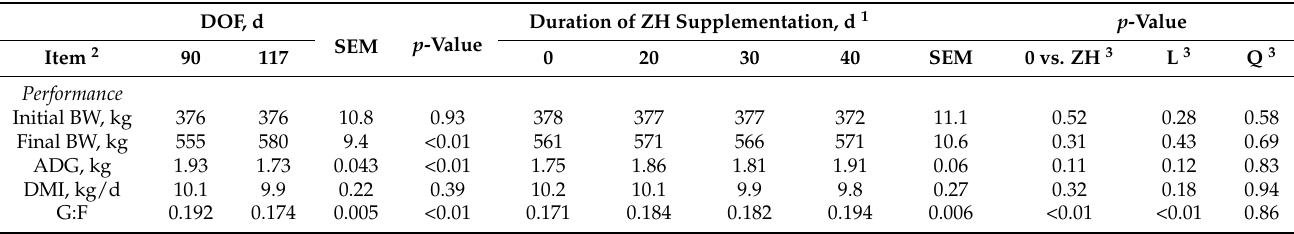
Table 2. Least square means, standard error of the mean (SEM), and probabilities of performance, according to the duration of zilpaterol hydrochloride (ZH) supplementation and days on feed